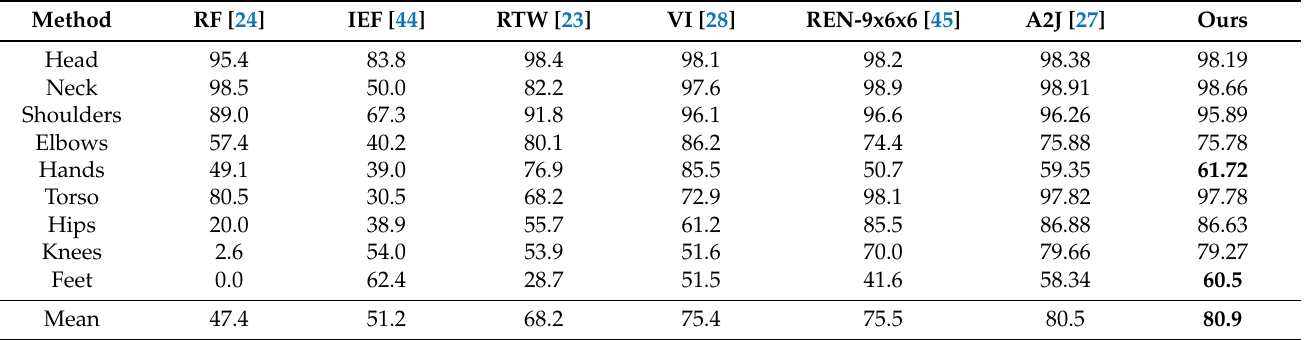
Table 2. Performance comparison on the ITOP top-view dataset. We evaluate the methods that use the metric of the mean average precision (mAP) with the 10-cm rule. We show the results of each human joint and the average results of all the human joints.